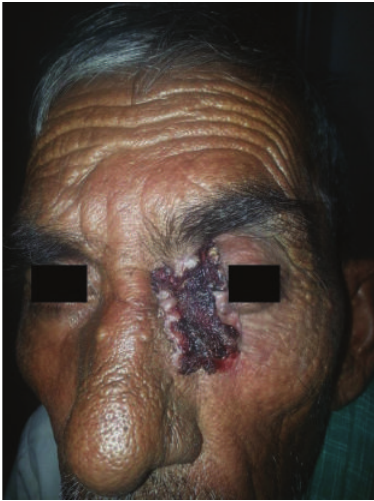
Figure 1: Preoperative image of BCC face involving medial canthus.